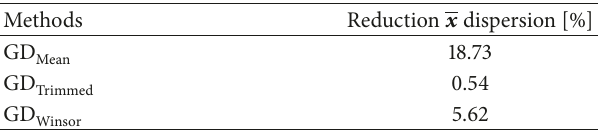
Table 16: Log-normal with 100 points.